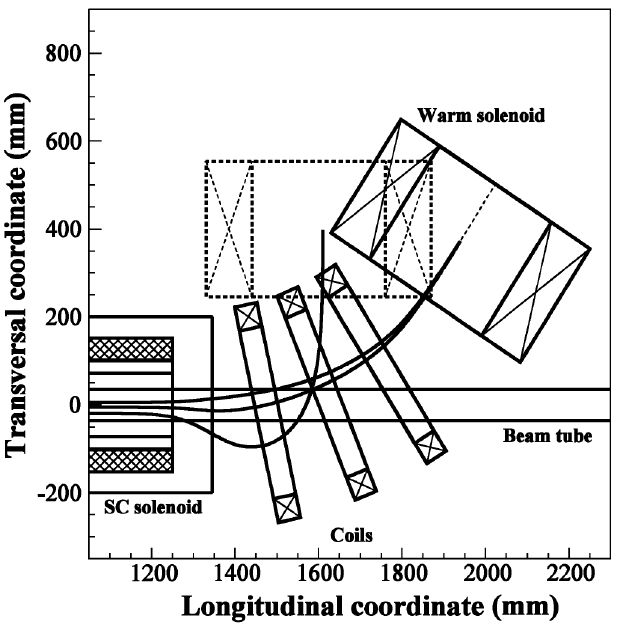
FIG. 3. Simulations of the magnetic field lines in the bending sections of the TEL-1 and TEL-2 carried out using the MULTIC code [30]. The placement of the TEL-1 gun solenoid is shown by dashed lines; TEL-2 magnets are represented by solid lines. Magnetic field lines (electron-beam trajectories) in both TELs are shown as